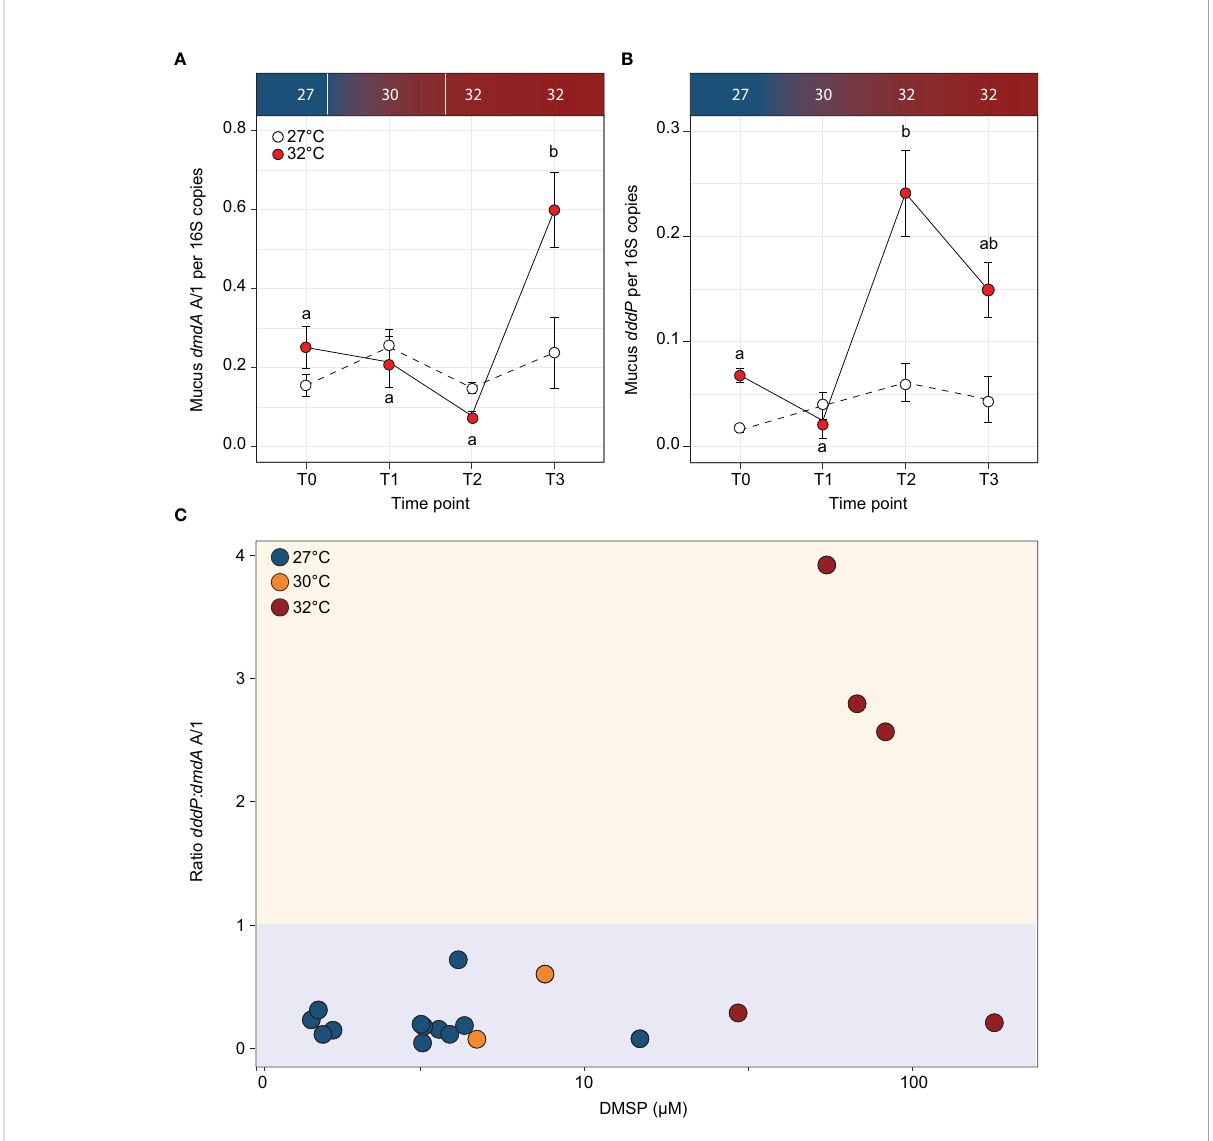
FIGURE 5 Abundance of DMSP degrading genes (A) dmdA A/1 and (B) dddP per 16S copies for each timepoint for the control (white circles) and temperature treatments (red circles) in the Acropora millepora mucus. Letters indicate signi fi cant differences between timepoints for the treatments. Averages (± SE) are shown (n = 3-5). (C) Ratio of dddP:dmdA A/1 (cleavage:demethylation pathway) to concentration of DMSP in Acropora millepora mucus for experimental temperatures 27°C (T0; blue circles), 30°C (T1; orange circles) and 32°C (T2 and T3; red circles). Ratio >1 (yellow shading) indicates when the cleavage pathway is higher than demethylation. When the ratio of dddP:dmdA is <1 (blue shading), the demethylation pathway is higher than the cleavage pathway. Temperature treatments are indicated along the top panel for corresponding sampling timepoints. DMSP concentration on the x-axis is on a log10